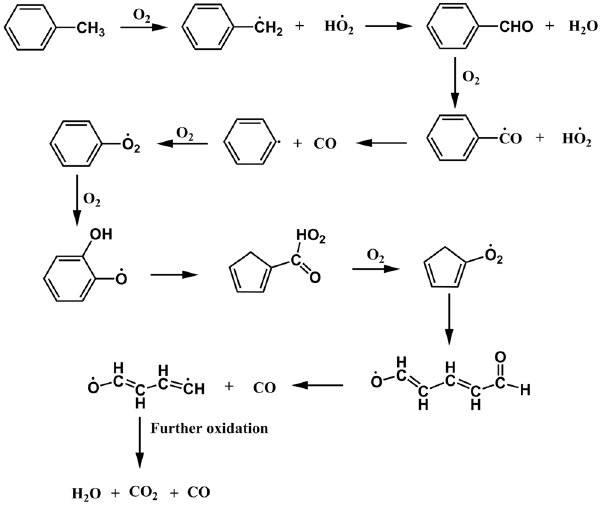
Figure 7. Toluene oxidation pathway through hydrogen abstraction reactions observed during ReaxFF NVT-MD simulations.